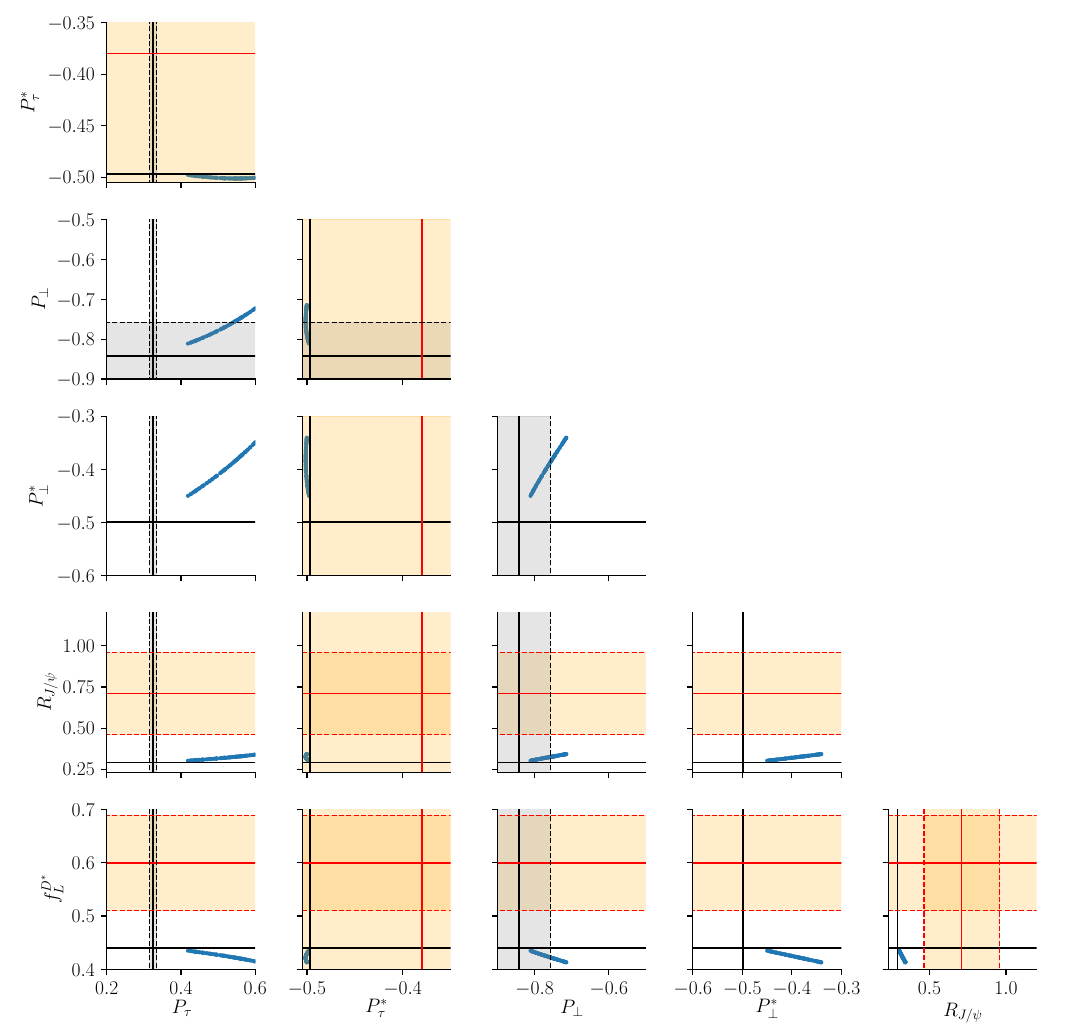
Figure 15. A grid plot of the various b ! c related observables in addition to R D and R D (cid:3) considered in our analysis. Solid black lines represent the SM predictions around which the grey shaded regions are the Belle II 50 ab (cid:0) 1 sensitivities [59], bordered by the black dashed lines. Red lines are current measurements and orange regions are their 1 (cid:27) errors. Where the Belle II sensitivity is unavailable we present only the SM prediction without a shaded region. The blue points explain R to 2 (cid:27) D ( (cid:3) )